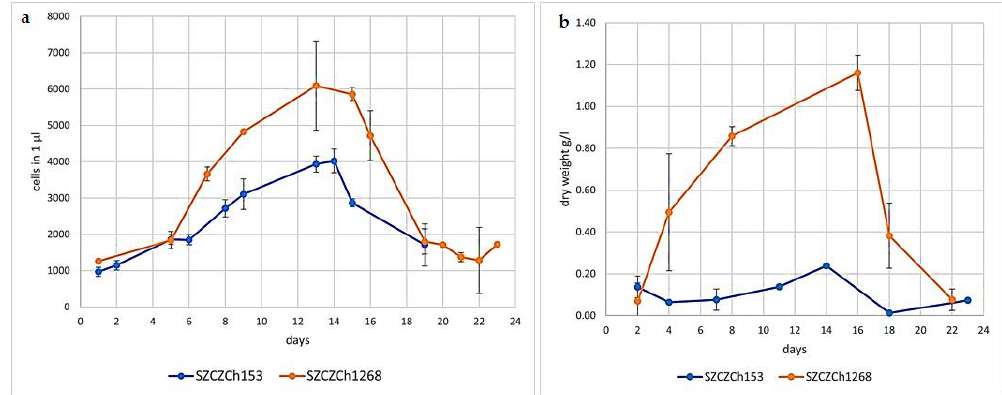
Figure 1. Growth curves for G. flavovirens (SZCZCh1268) and G. mutabilis (SZCZCh153): ( a ) density of cells in 1 mL per day; ( b ) dry biomass (g·L −1 ).